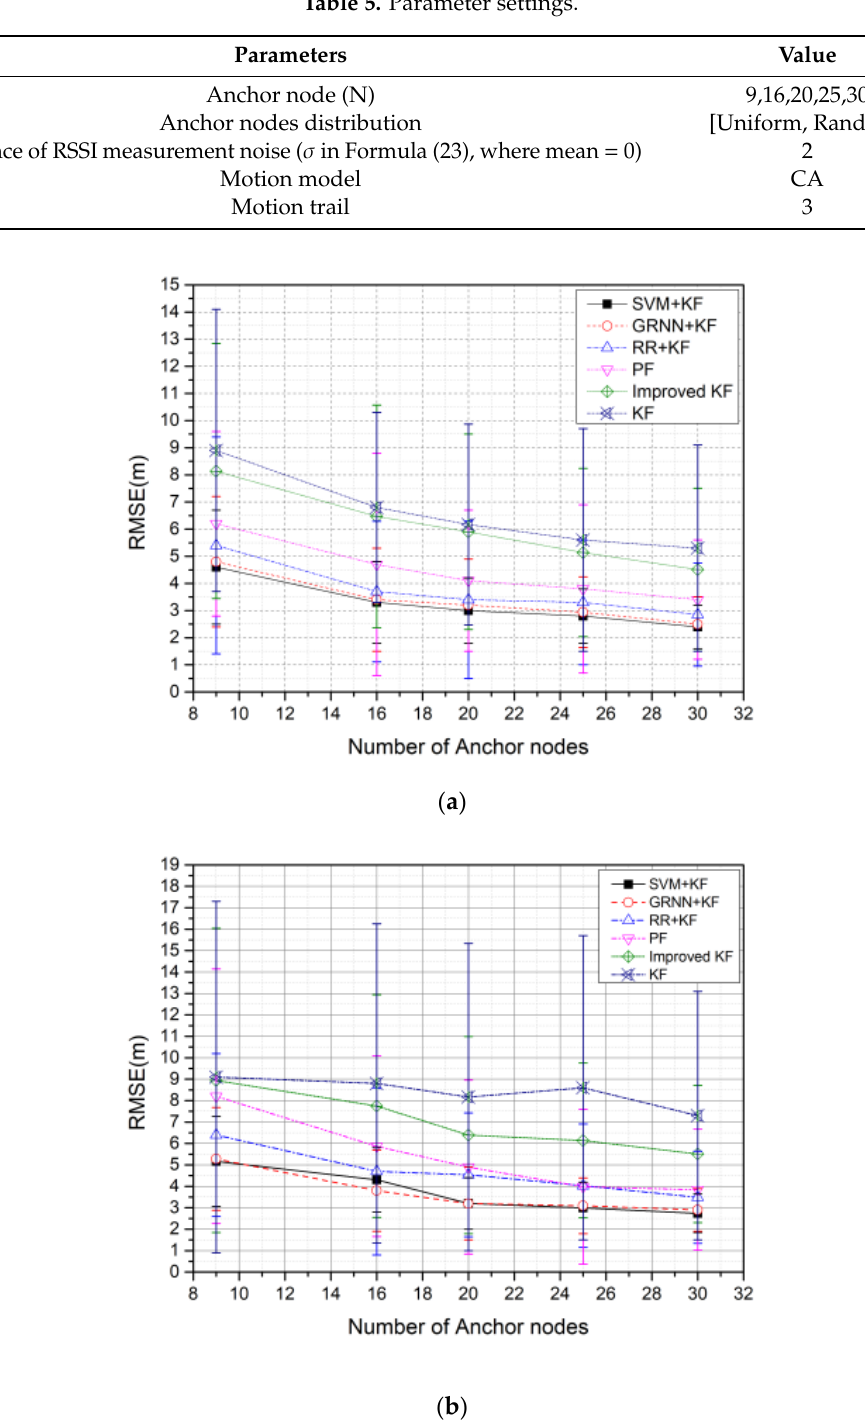
Figure 9. RMSE versus number of anchor nodes with 100 rounds: ( a ) Anchor nodes with a uniform distribution; ( b ) anchor nodes with a random distribution.